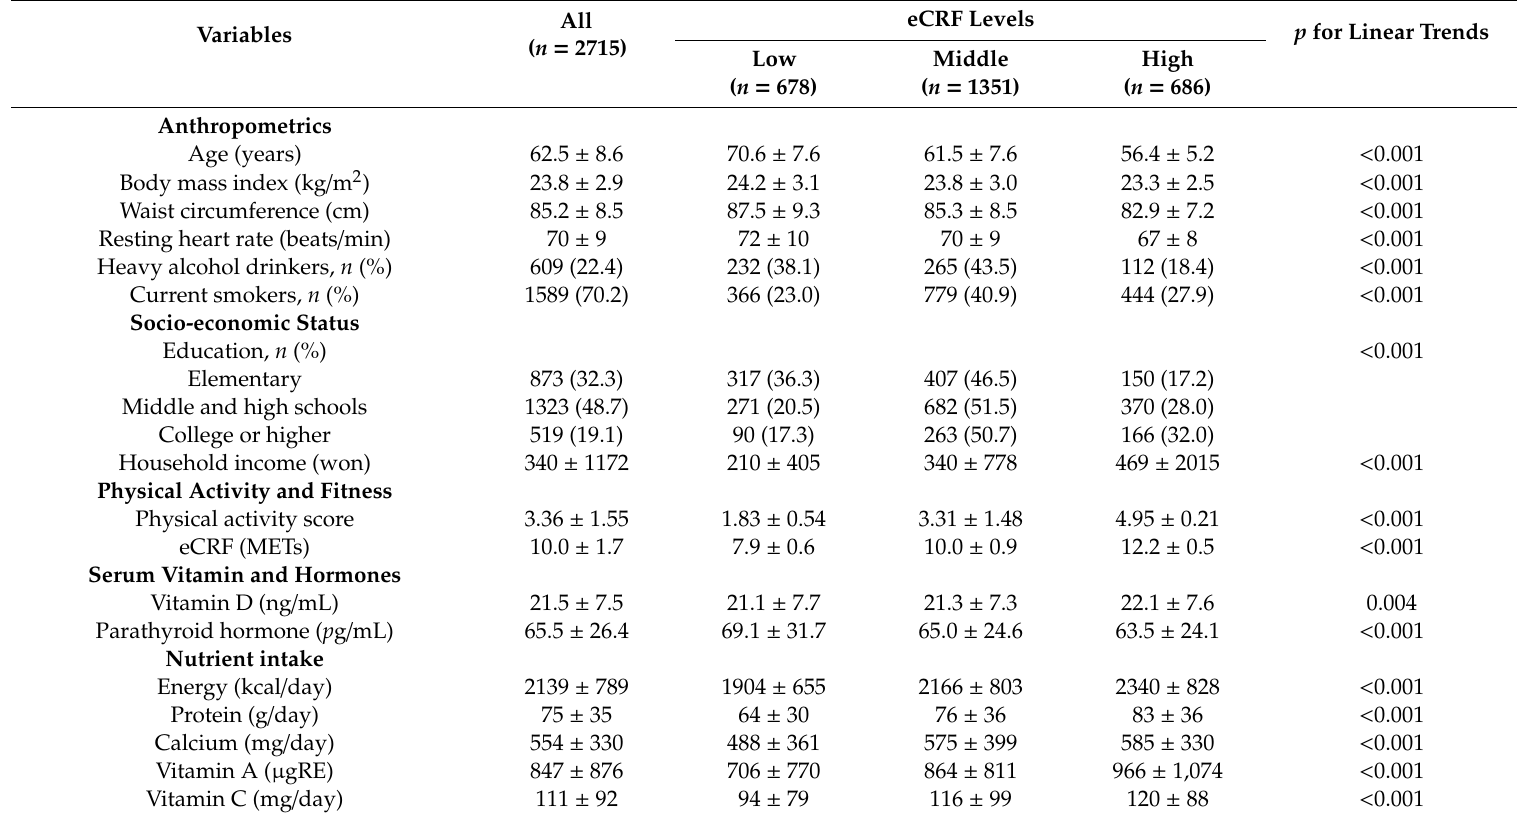
Table 1. Description of measured parameters according to estimated cardiorespiratory fitness (eCRF) levels.